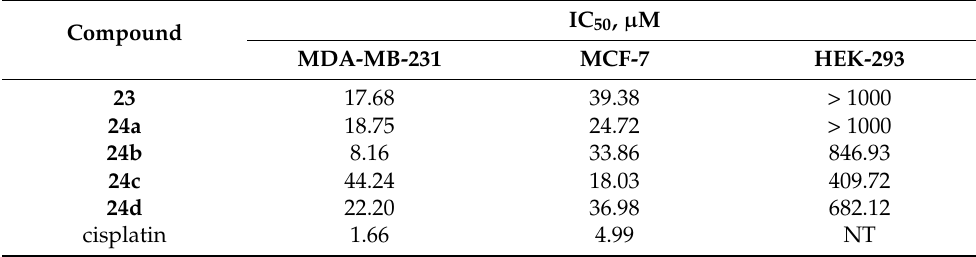
Table 2. The anticancer activity of quinolinone-thiazolidin-4-one hybrids 23 and 24a – 24d .